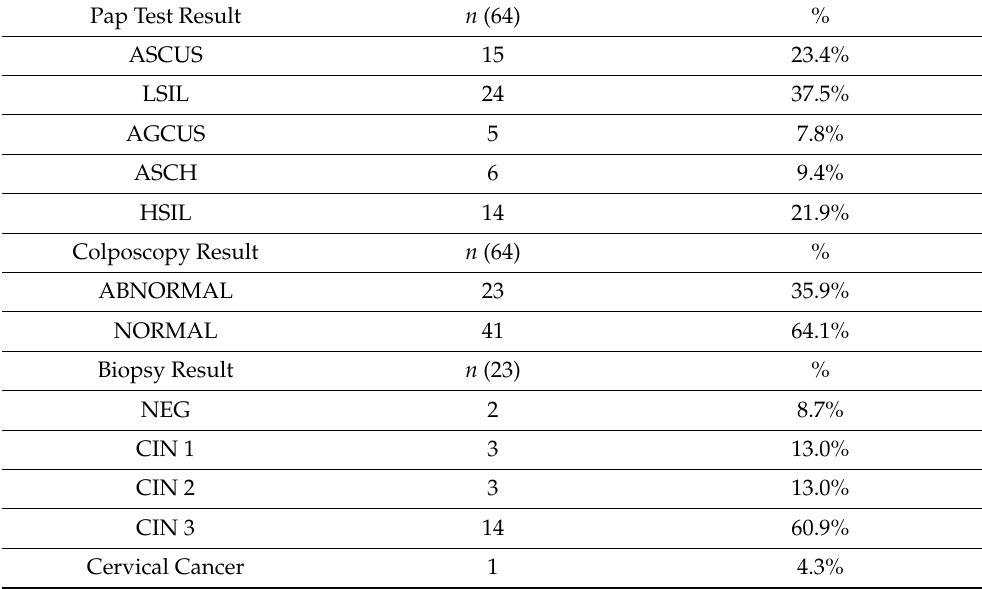
Table 1. Clinical data of patients enrolled. Low-grade intraepithelial lesion (LSIL); atypical squa- mous cells of undetermined significance (ASCUS); high-grade intraepithelial lesion (HSIL); atypical glandular cells of undetermined significance (AGCUS); cervical intraepithelial neoplasia